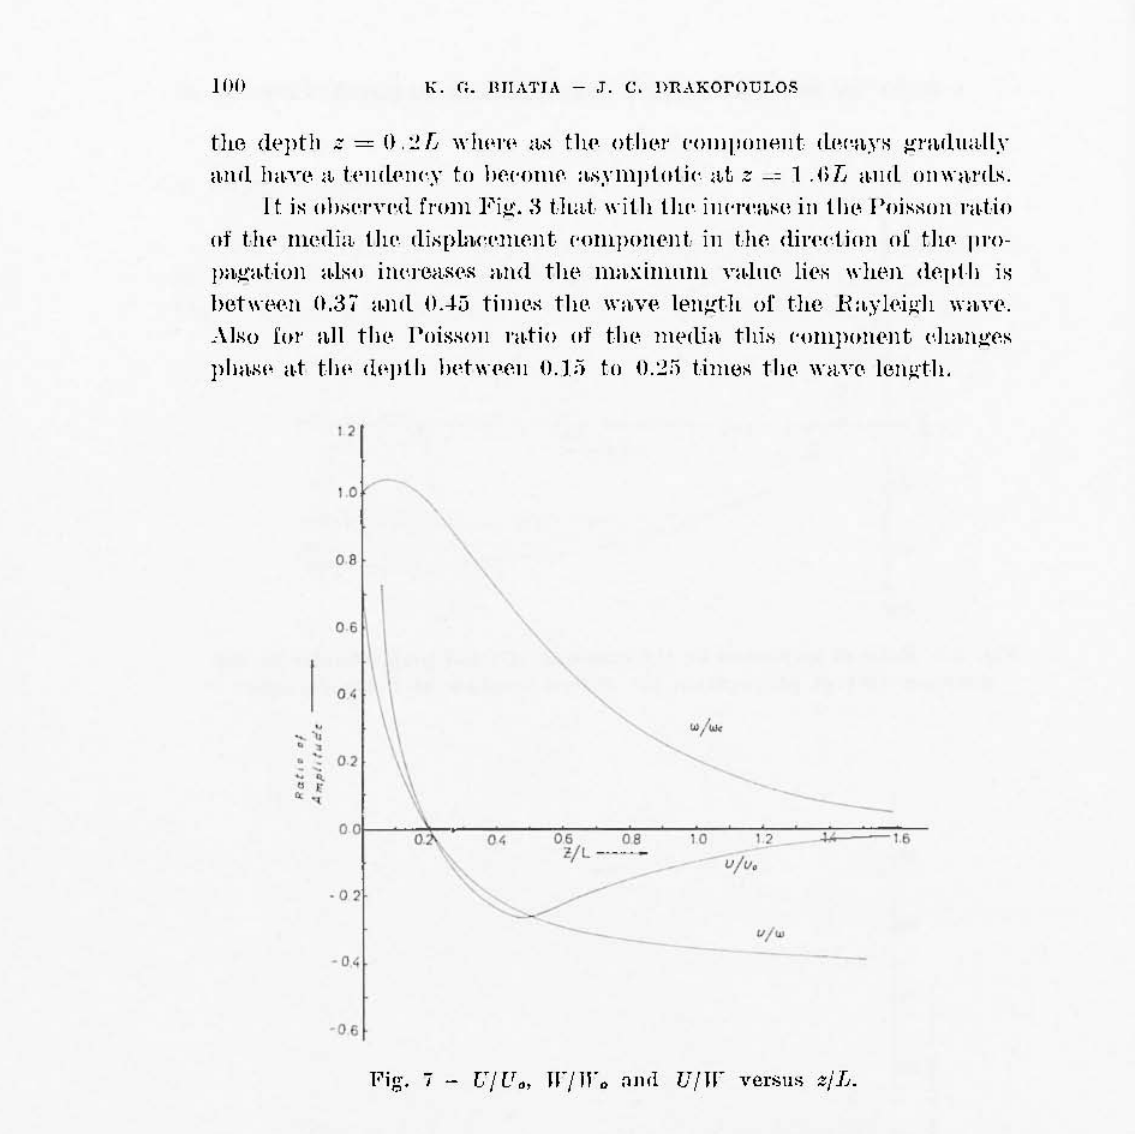
Fig. ""i - [;/(10, II"jl!'" ilJHI U/II" verS\l;;